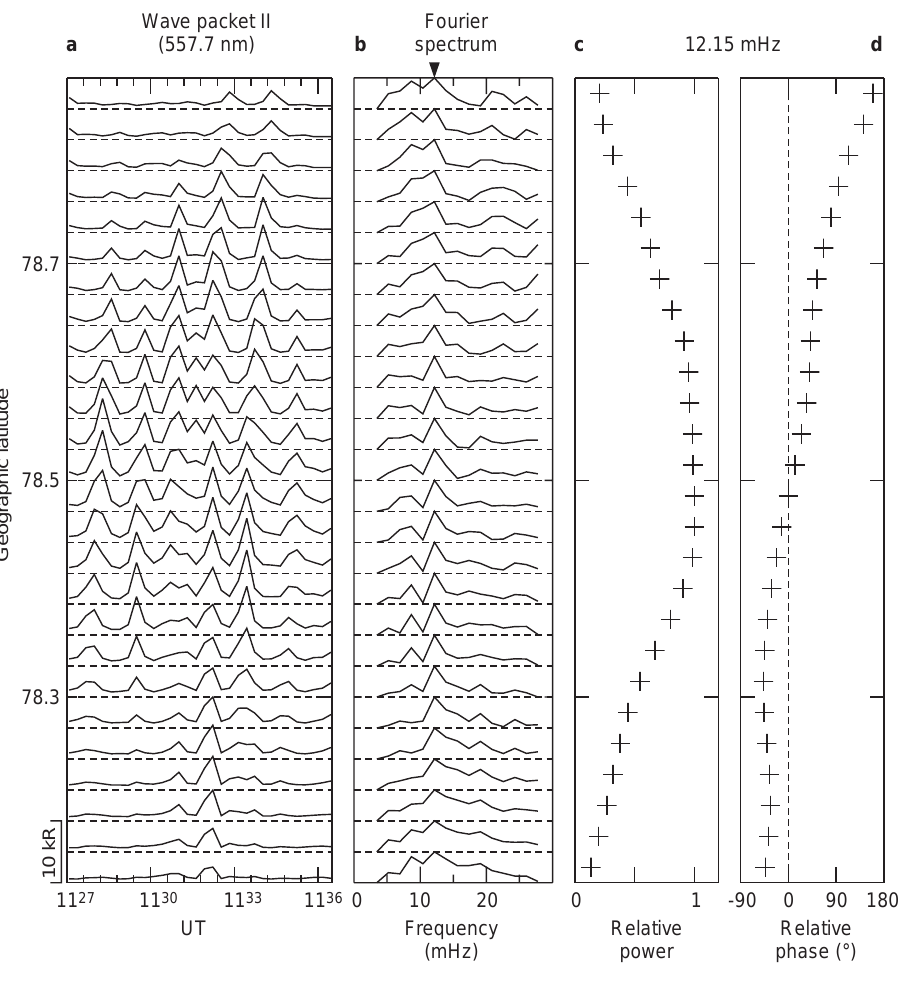
Fig. 7a–d. Spectral analysis of the green line observations of wave